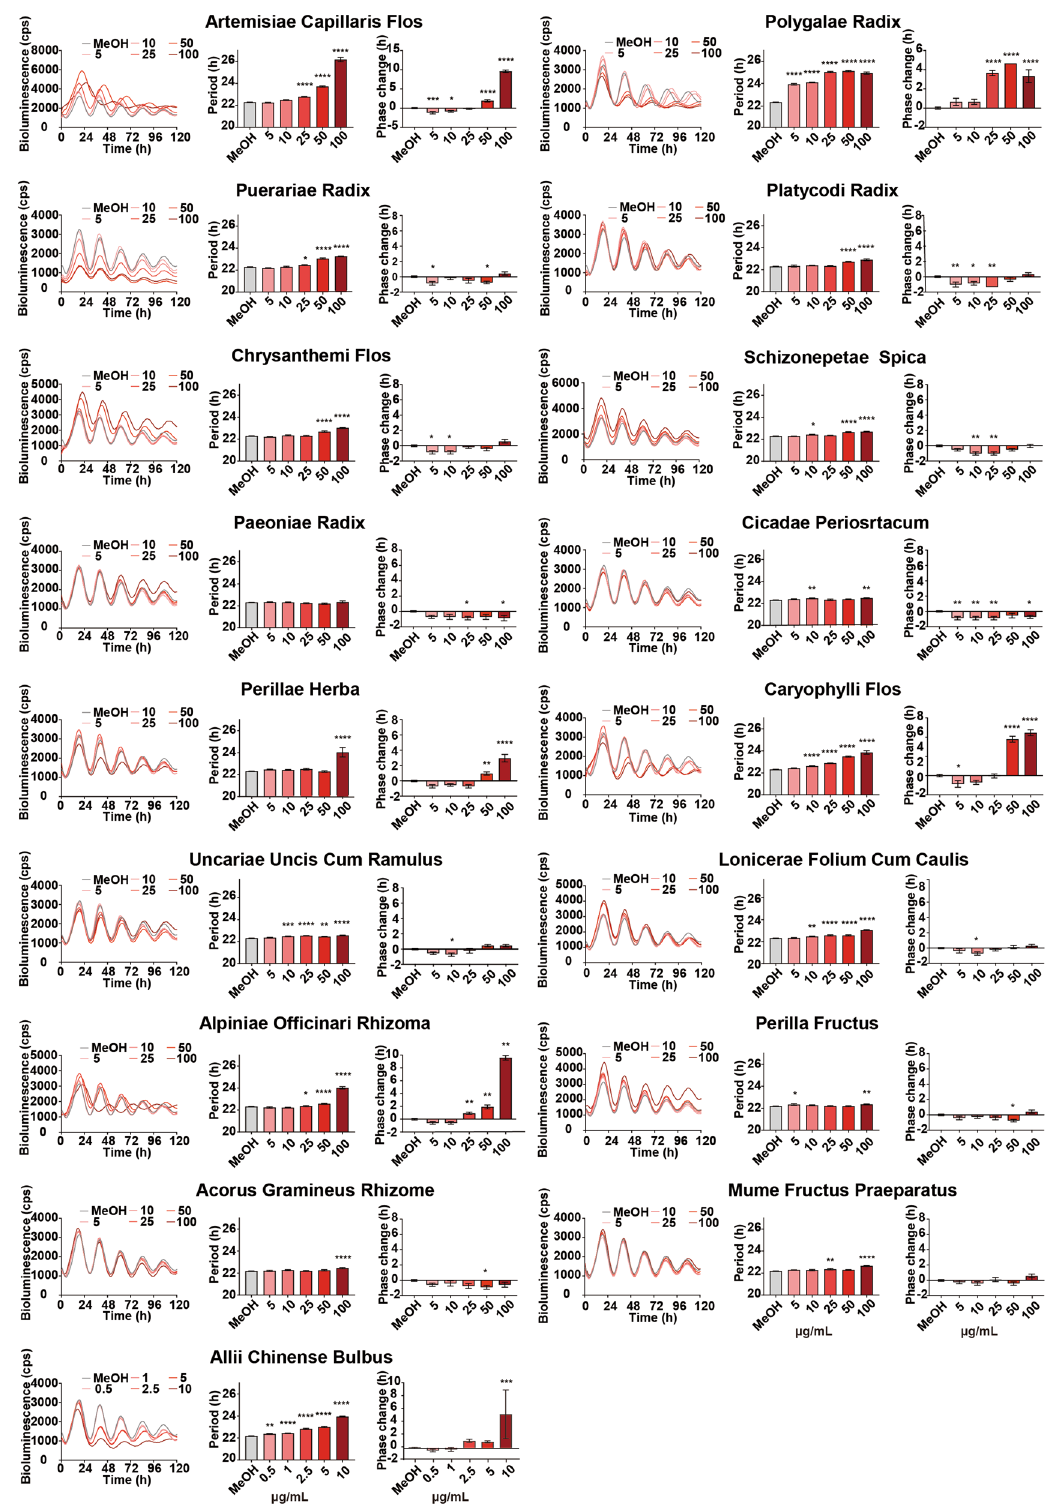
Figure 2. Dose-dependent effect of 17 hit crude drug extracts in U2OS cells expressing Bmal1-dLuc . Luminescent traces (left) and dose-dependent effects on the circadian period (middle) and phase (right) in U2OS cells. Values are averages of six replicates ± SD and were analyzed using one way ANOVA, followed by Dunnett’s multiple comparisons test (* p < 0.05, ** p < 0.01, *** p < 0.001, **** p <